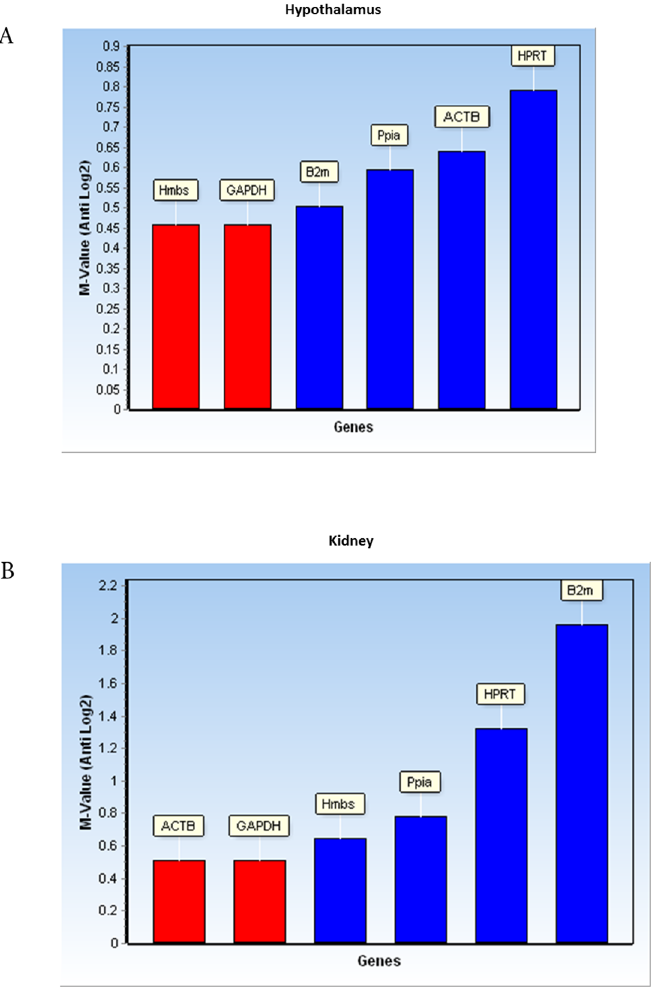
Fig 3. Gene stability value in hypothalamus (A) and kidney (B) is estimated by geNorm. The calculation is basedon pairwisecomparisonbetweengene of choice and all other tested genes. M-value > 1.5 will be eliminated from pairwiseanalysis.